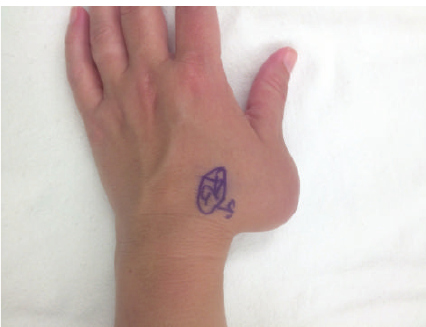
Figure 5: Preoperative photograph of the left hand demonstrating a large thumb